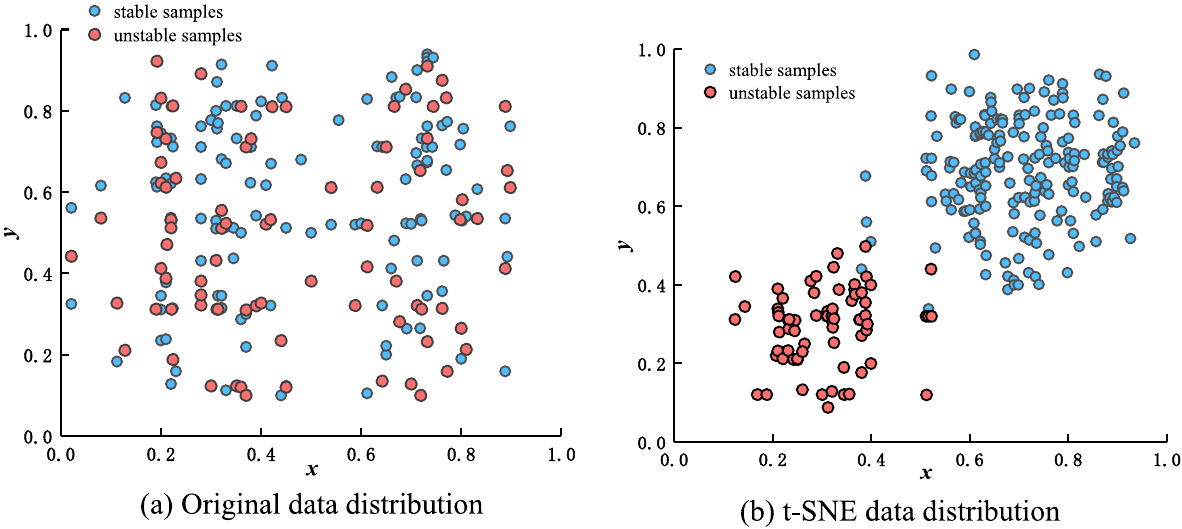
Fig. 13 t-SNE result on the IEEE 145-bus